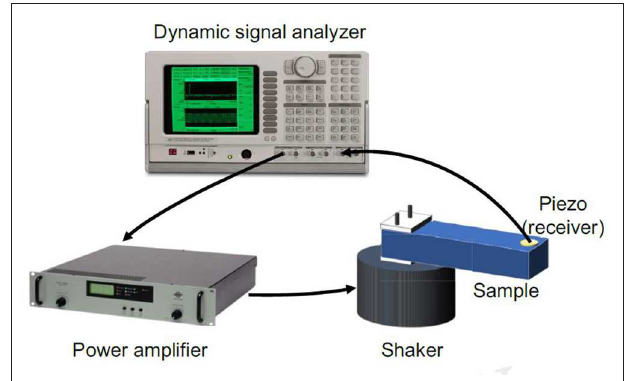
FIGURE 3 | Experimental setup for the polymer concrete sample: dynamic signal analyzer (Stanford research system model SR785), power amplifier